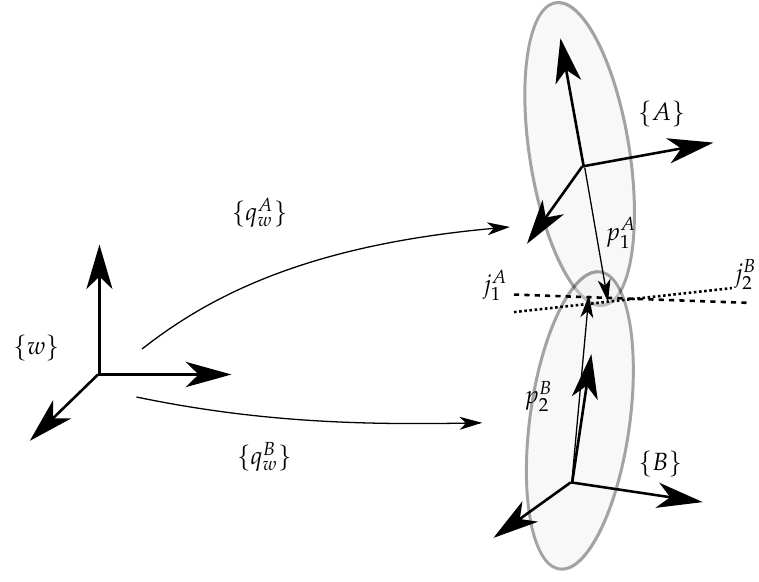
Figure 1. Schematic representation of the reference frames: world frame { w } , sensor frame { A } , sensor frame { B } , q A w is the quaternion rotating the world reference frame into the reference frame { A } , q B w is the quaternion rotating the world reference frame into the reference frame { B }